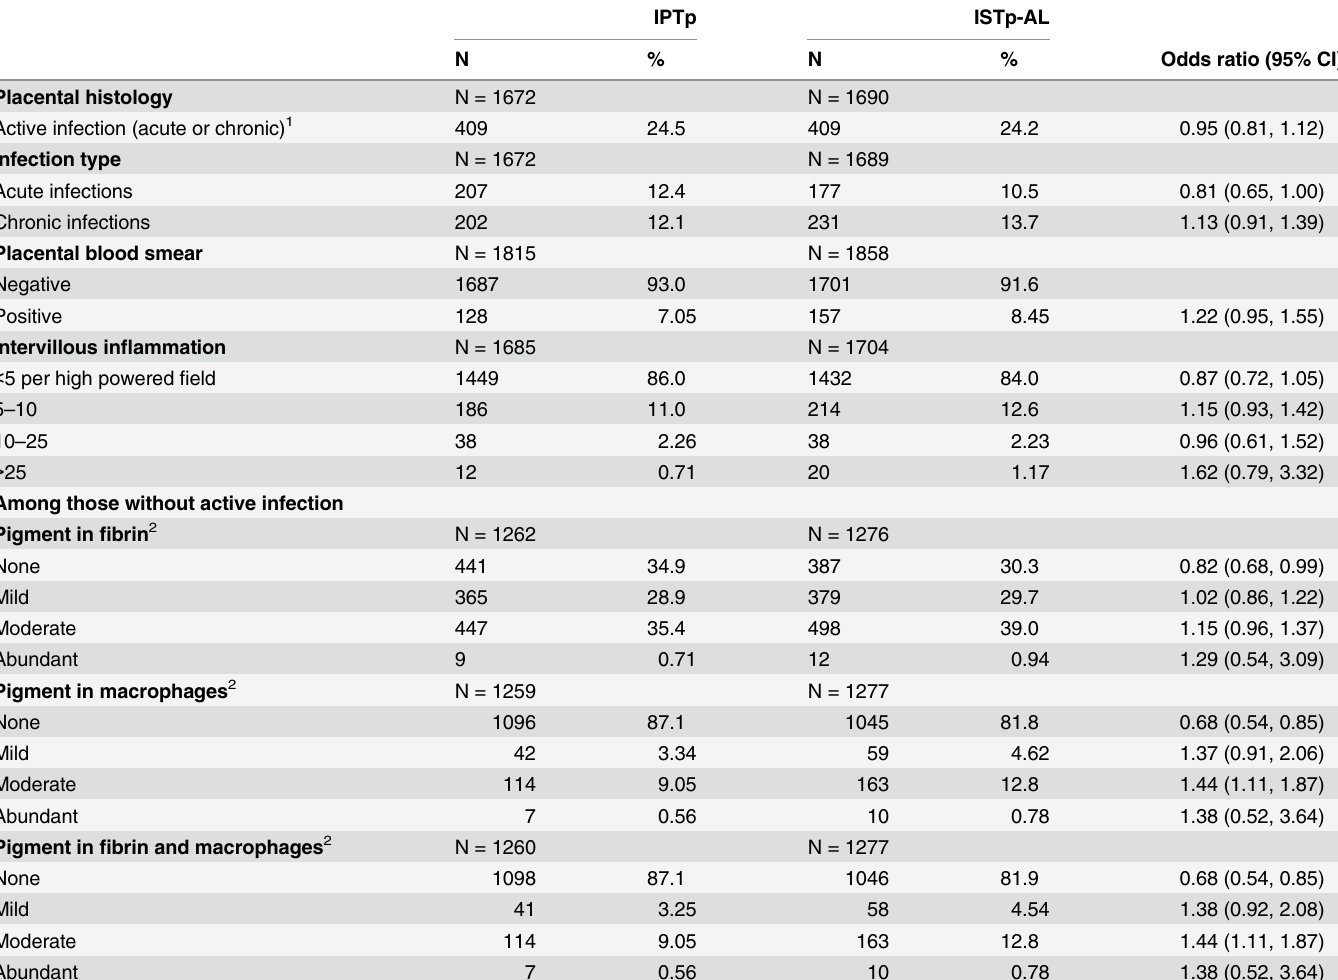
Table 3. Prevalence of placental malaria by study